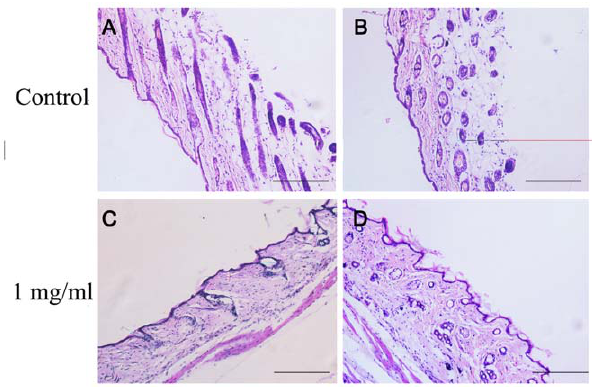
Figure 5. 6-Gingerol decreased the number of hair follicles in C57/BL6 mice. After depilation the back, the skin was treated with vehicle alone (control) or 1 mg/ml 6-gingerol every day for 10 days. The effect of 6-gingerol on the hair follicles was analyzed using staining with H&E at 20 days after depilation. (a)–(c) Longitudinal sections of the dorsal skins. (b)–(d) Transverse sections of the dorsal skins. Each scale bar represents 200 m m.